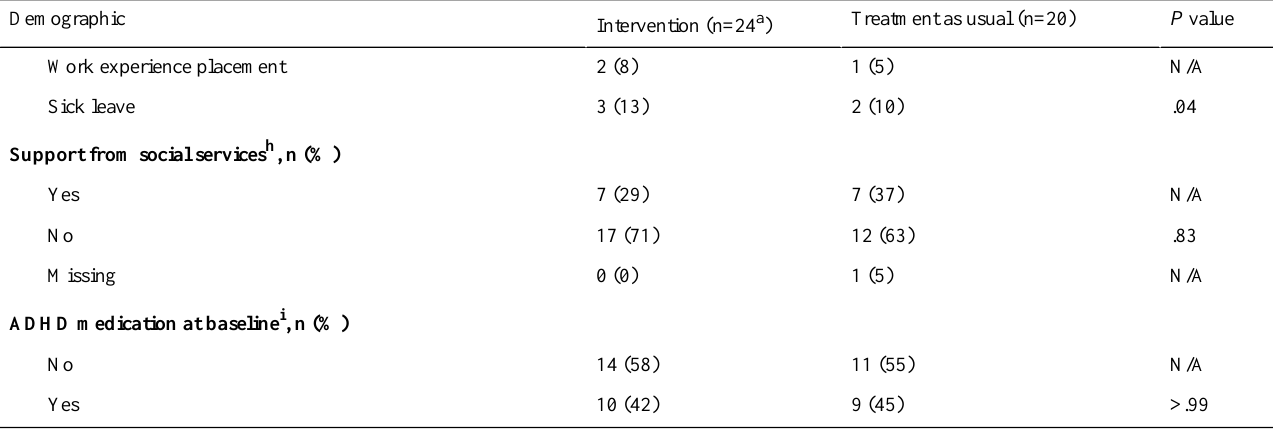
table. b N/A: not